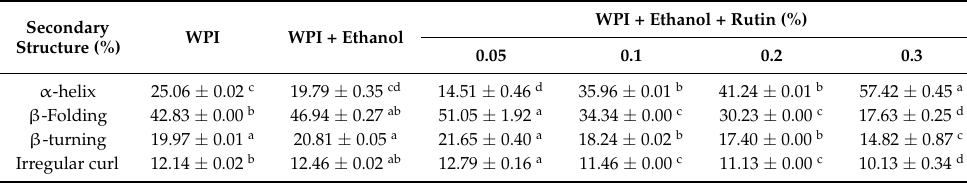
Table 1. The effects of ethanol (15% v / v ) and different levels of rutin (0.05%, 0.1%, 0.2% and 0.3% w / v ) on the secondary structure of WPI. Means in the same row with different letters (a–d) differ significantly ( p <